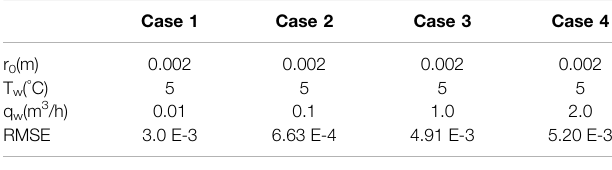
TABLE 3 | RMSE value at different fl ow velocity, for Example three.